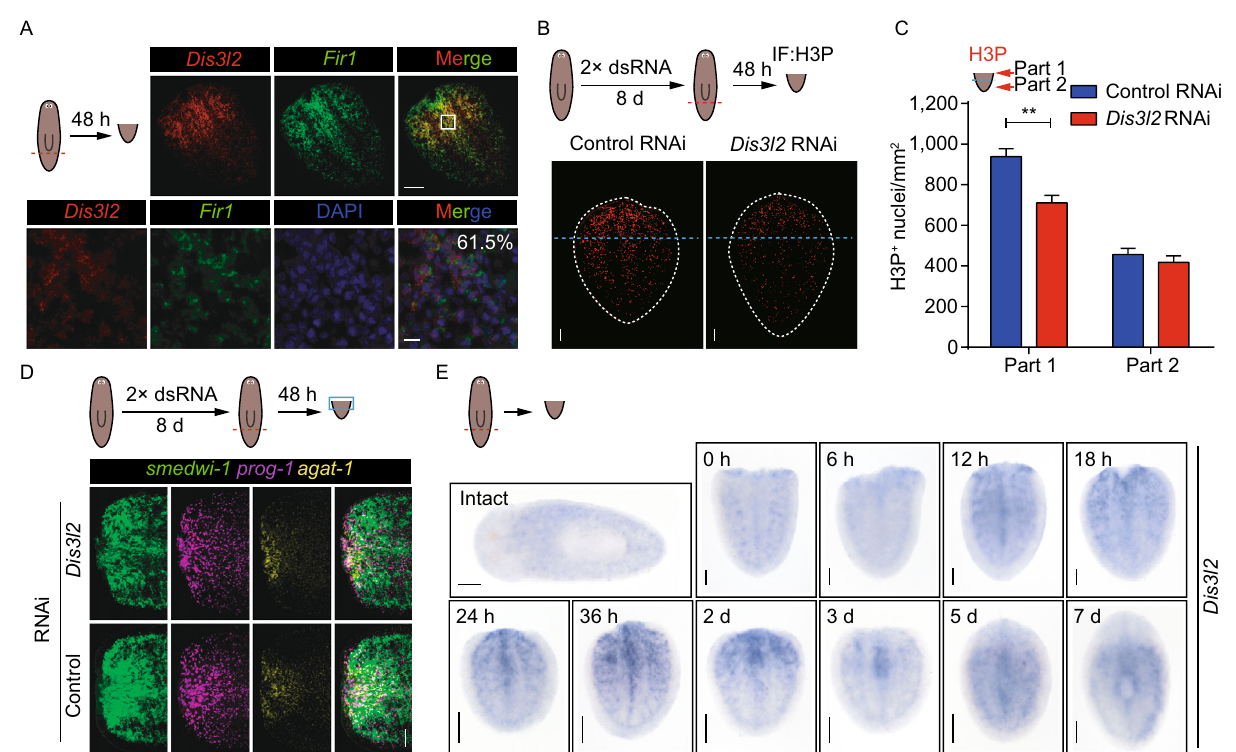
Figure 5. Fir1 functions through regulation of Dis3l2 . (A) Representative confocal projections through wildtype tail pieces fi xed 48 h post-amputation, labelled with Dis3l2 (red), Fir1 (green) and DAPI (blue). Box indicates zoomed-in region. The number indicates the percentage of Dis3l2 + cells co-expressing Fir1 ( n = 561 cells). Ventral view; scale bar, upper panel: 50 μ m; lower panel: 10 μ m. (B) Representative confocal projections through tail pieces fi xed 48 h post-amputation following RNAi administration, stained with H3P antibody. Dotted lines (white): tail piece boundary. Scale bars, 100 μ m. Dotted lines (blue) separate the tail pieces into two parts for quanti fi cation in (C). (C) Mitotic density in part 1 and part 2 as separated in (B). Error bars represent SEM; ** equals P < 0.001; signi fi cance determined by Student ’ s t test. (D) The neoblast population adjacent of the wound sites reduced in Dis3l2 (RNAi) tail pieces as assayed with neoblast lineage markers ( smedwi-1 for neoblast, prog-1 for neoblast early progeny and agat-1 for neoblast late progeny). Scale bars, 100 μ m. (E) Colorimetric WISH of intact animals and regenerating middle pieces for Dis3l2 . For each time point, n = 6 animals. Scale bars, 200